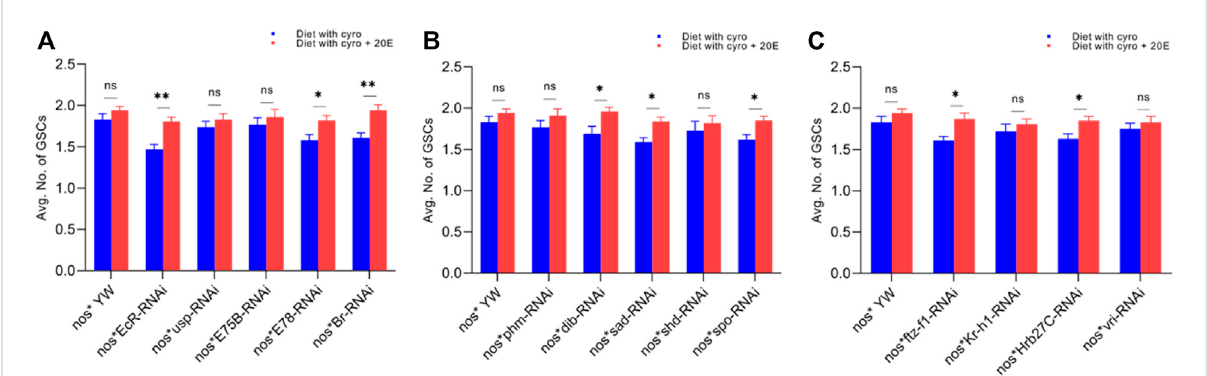
FIGURE 6 Rescue experiment of GSCs. (A) The number of GSCs against ecdysone-responsive primary genes. (B) The number of GSCs against Halloween genes. (C) The number of GSCs against ecdysone-responsive genes. The blue bars indicate the numbers of GSCs against thecyromazinetreatment, while red bars indicate the numbers of GSCs from the fl ies fed on a diet containing 20E with the cyromazine. For the t -test: * p < 0.05; ** p < 0.01; *** p < 0.001; ns indicates not signi fi cant ( p > 0.05).